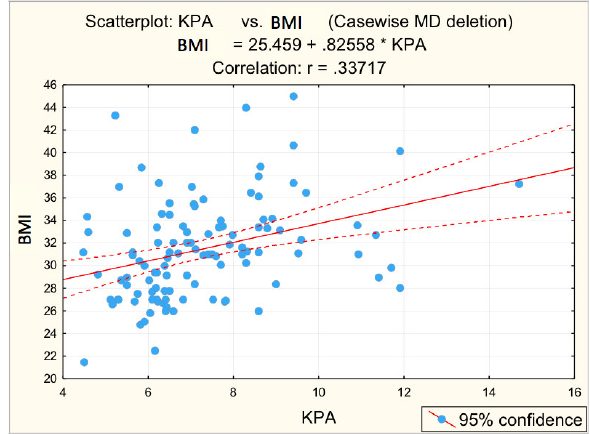
Diagnostics 2022 , 12 , x FOR PEER REVIEW 8 of 13 Figure 6. Correlation BMI—fibrosis . Figure 6. Correlation BMI—fibrosis.